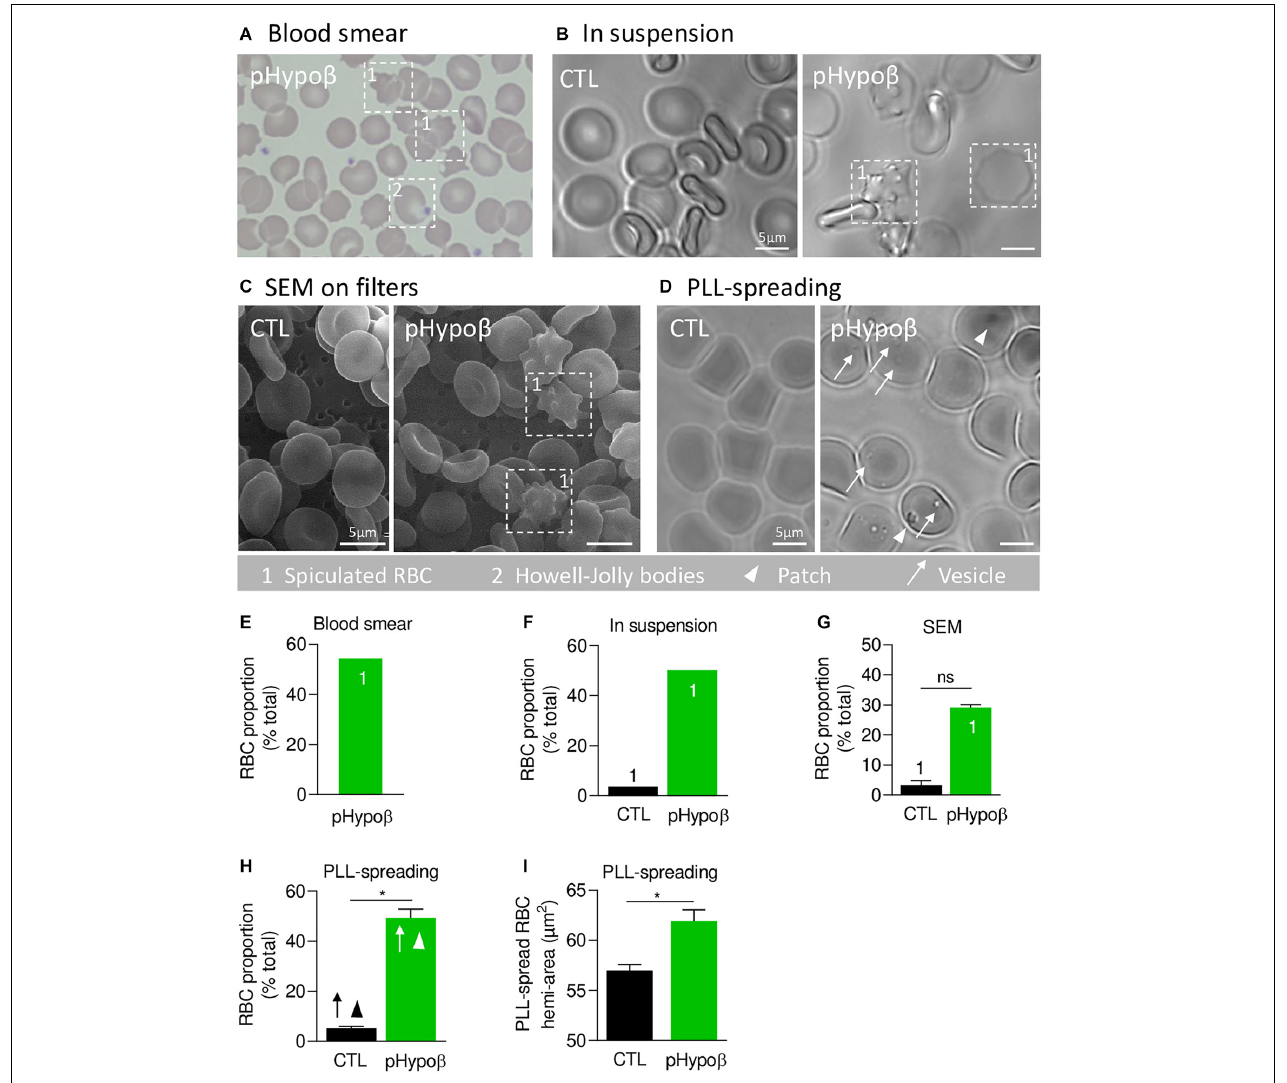
FIGURE 1 | A high proportion of acanthocytes is visible on pHypo β blood smears and RBCs in suspension while patches and small vesicles are evidenced upon RBC spreading. The morphology of RBCs of the patient with hypobetalipoproteinemia (pHypo β ; green columns) was compared to those of healthy donors (CTL; black columns), either on blood smear (A) , on RBCs in suspension (B,C) , or upon spreading on poly- L -lysine (PLL)-coated coverslips (D) . Then, the proportion of RBCs with spicules (indicated with 1; E–G ), patches (arrowheads, H ) and/or vesicles (arrows, H ) and the RBC membrane area were determined (I) . (A) May–Grünwald Giemsa-stained blood smear. 1, spiculated RBCs; 2, Howell-Jolly bodies. (B) Light microscopy of living RBCs in suspension in IBIDI chambers. Images are representative of 2 independent experiments. (C) Scanning electron microscopy of glutaraldehyde-fixed RBCs on filters. Images are representative of 2 experiments with 3 filters each. (D) Light microscopy of living RBCs spread on PLL-coated coverslips. Images are representative of at least 10 experiments. (E–G) Quantification of the abundance of spiculated RBCs, expressed as % of total RBCs. Data are means from 1 experiment for (E,F) and means ± SEM of 3–4 filters in (G) . Mann–Whitney test; ns, not significant. (H) Quantification of the proportion of PLL-spread RBCs presenting patches and/or vesicles. Data are means ± SEM of 3–6 independent experiments. Mann–Whitney test; * p < 0.05. (I) Quantification of the membrane surface area of PLL-spread RBCs. Data are means ± SEM of 6–7 independent experiments. Mann–Whitney test; * p <